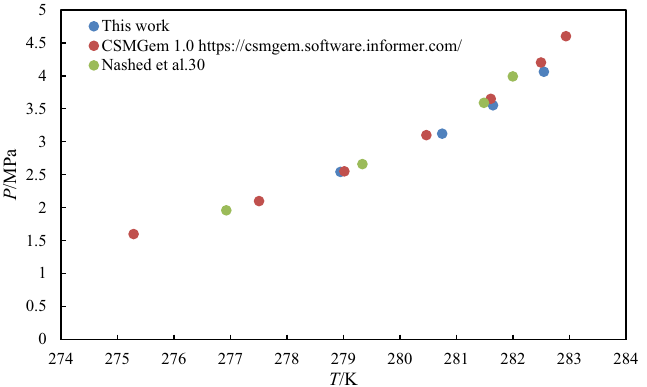
Figure 1. Comparison of CO 2 hydrates equilibrium conditions of pure water with CSMGem 1.0 software and literature 31